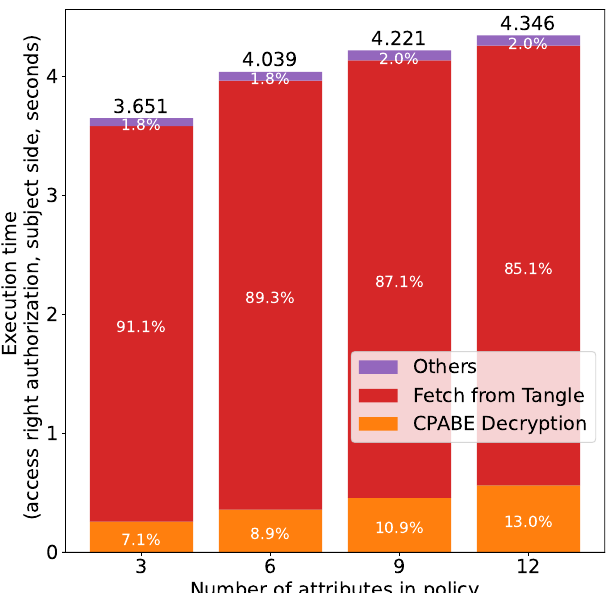
Figure 17. Access right authorization time (subject) vs. number of